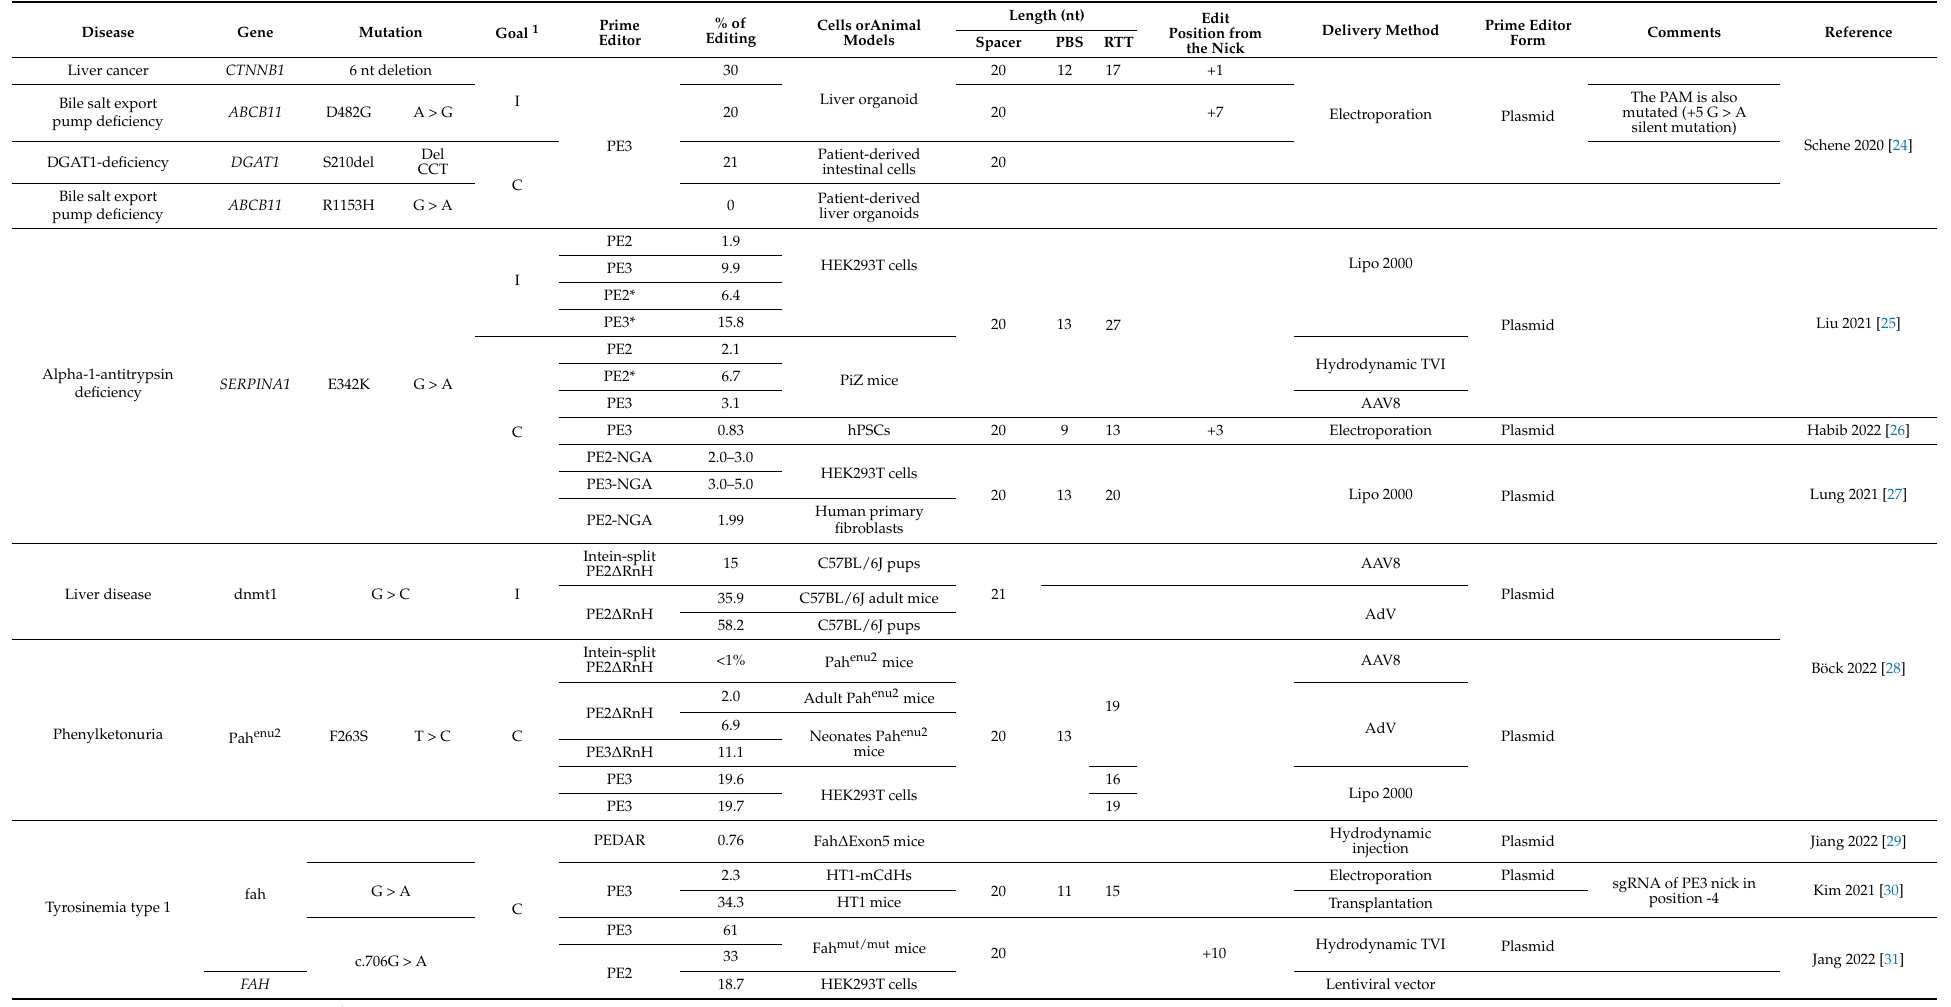
Table 2. Prime editing studies on correcting or introducing mutations causing liver